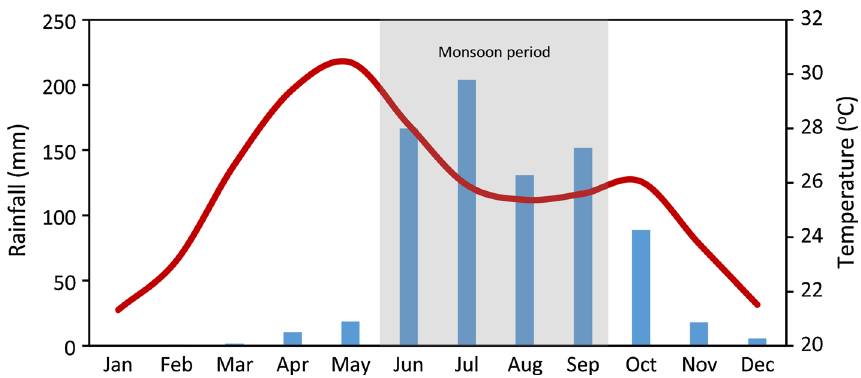
Fig. 11 Monthly rainfall distribution of the study area. The blue bar and the red line are indicating amount of rainfall and temperature, respectively